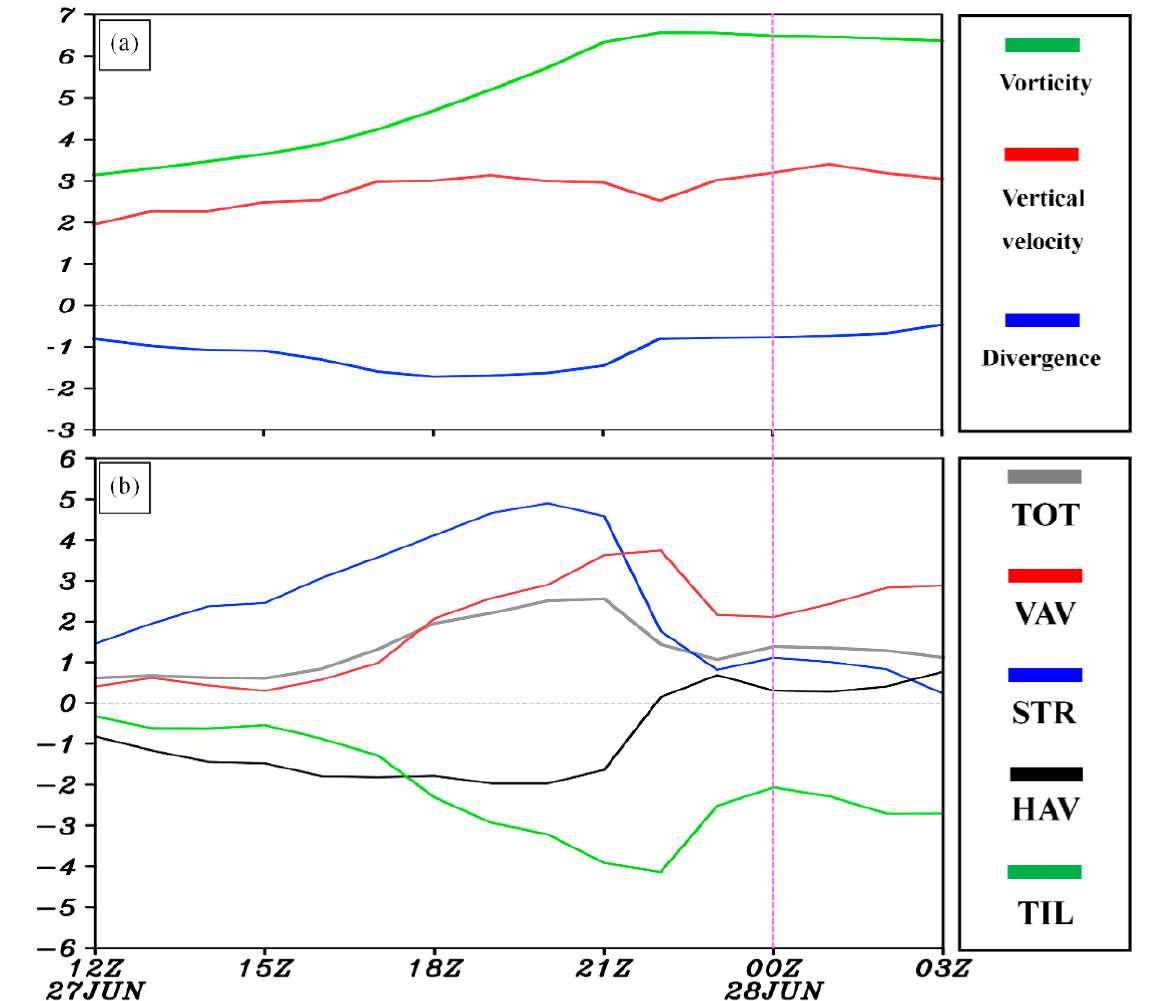
Figure 6. Panel ( a ) shows the central region averaged vorticity (units: 10 − 5 s − 1 ), divergence (units: 10 − 5 s − 1 ), and vertical velocity (units: cm s − 1 ) at 850 hPa. Panel ( b ) shows the central region averaged vorticity budget terms (units: 10 − 9 s − 2 ) at 850 hPa. The grey dashed lines mark the value of “0”, and the purple dashed lines mark the time when the mesoscale vortex formed. Y labels indicate the values of the variables on the right side.